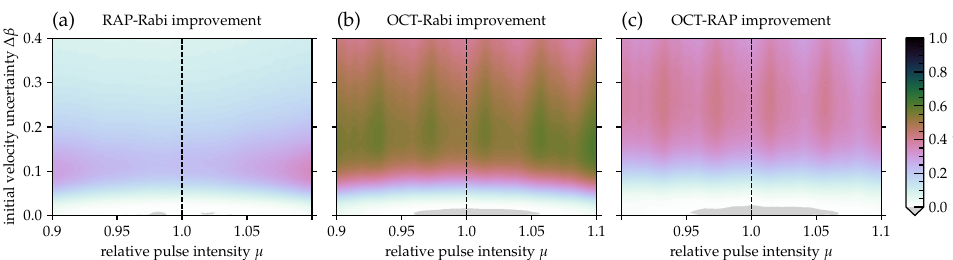
Figure 5. Contrast improvement between different schemes. Panel ( a ) shows the difference between Figure 4a,b, that is, between a scheme using a train of π /2 and π Rabi pulses and a scheme using rapid adiabatic passage (RAP). Panels ( b , c ) show the difference between Figure 4a,c, respectively Figure 4b,c; that is, between a scheme using pulses derived from optimal control theory (OCT) and the two analytic schemes (Rabi, RAP). The light gray points mark a (negligible) loss of contrast, < 0.04 in panel ( a ) and < 0.01 in panels ( b , c ∆ C ∆ C | | | |